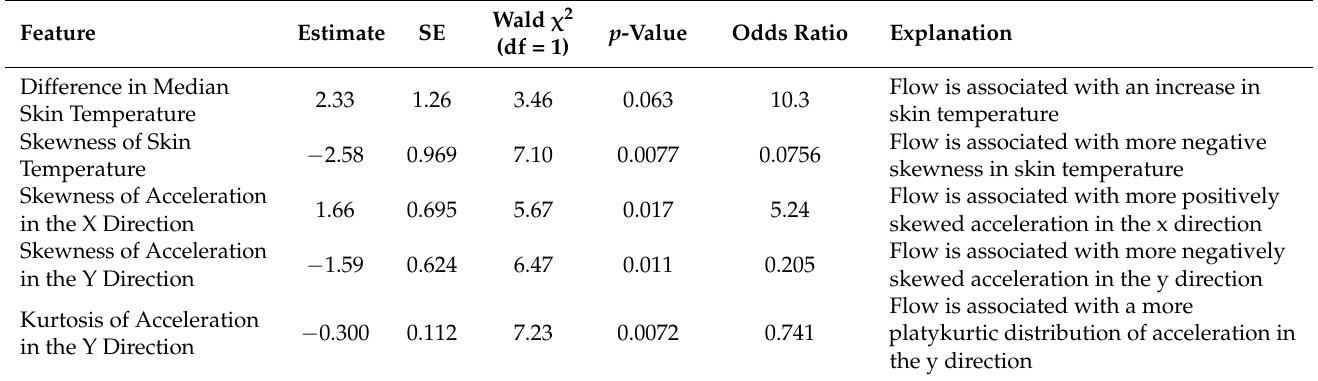
Table 2. Statistically significant features for prediction of flow after controlling for between-participant differences (not